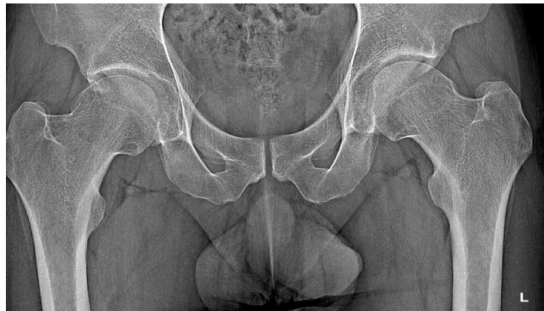
Figure 1. X-ray examination of the hip joints with the features of FAI.